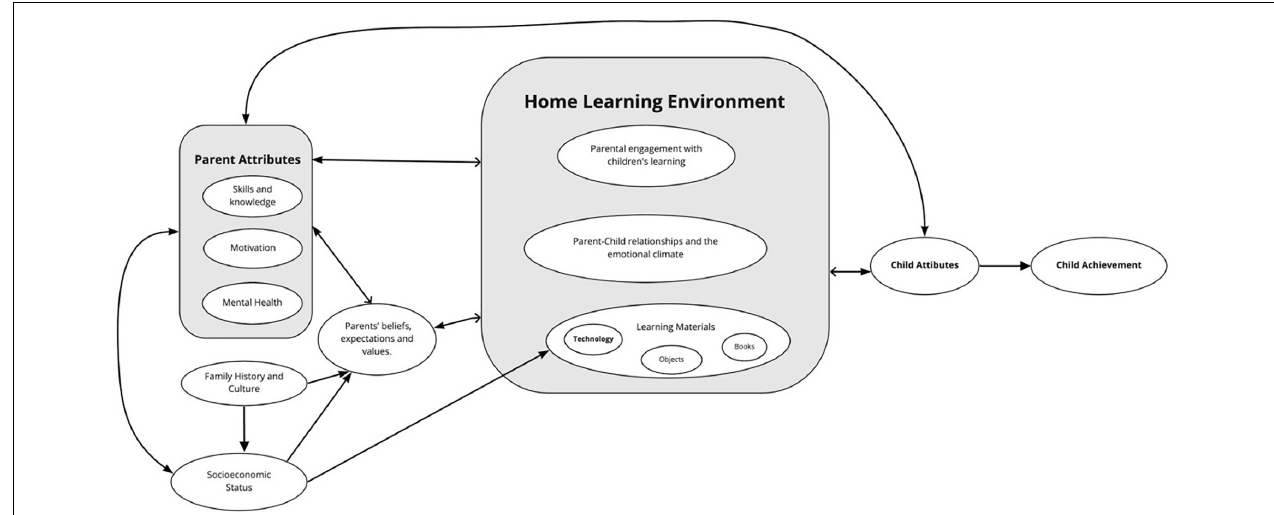
FIGURE 1 | Conceptual model of home learning environment adapted from Dearing and Tang (2010, p.